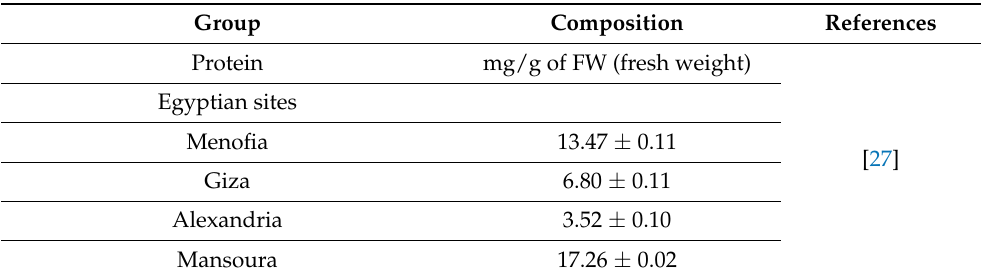
Table 1. Nutritional and essential oil component composition of Annona squamosa L.